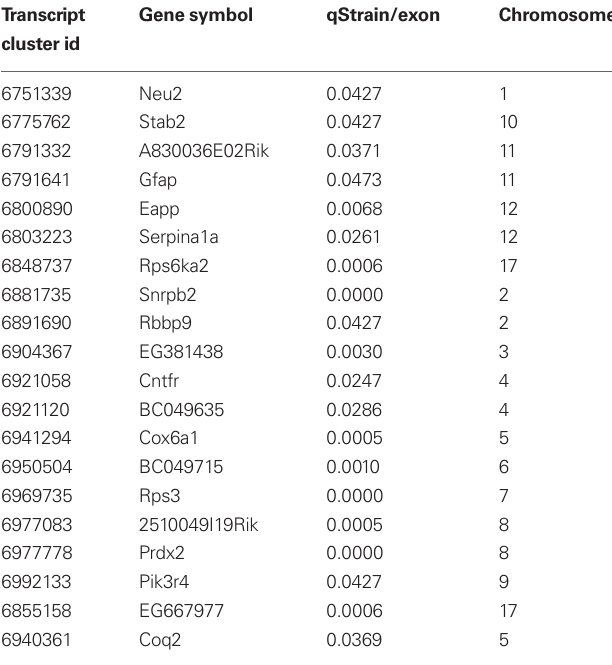
Table A1 | Putative strain-specific alternative exon usage candidates based on gene/transcript-cluster level annotation. There is a 25-fold reduction in the number of transcripts identified here as compared with the transcript-based model in Table S1 in Supplementary